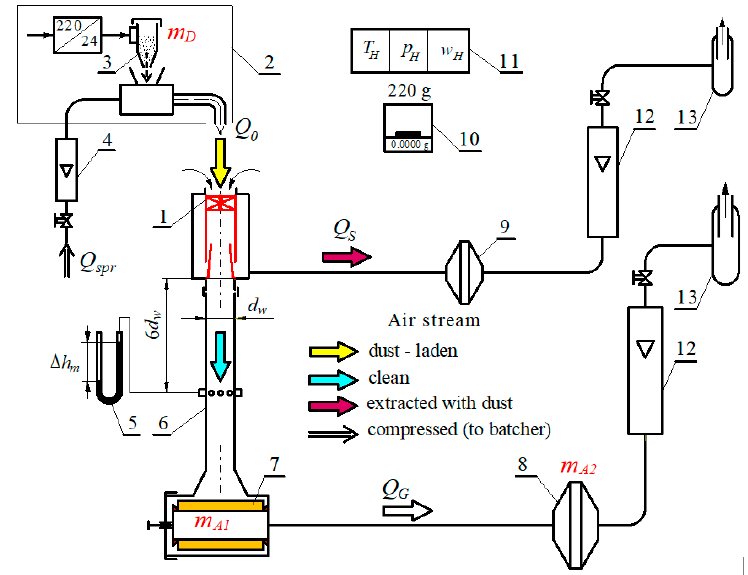
Figure 14. Functional diagram of the test stand for axial-flow cyclones: 1—tested axial flow cyclone, 2—dust dispenser, 3—dust container, 4—compressed air measuring rotameter, 5—U-tube liquid manometer, 6—outlet pipe from cyclone 7—measuring absolute filter A1 of the main stream, 8—measuring absolute filter A2 of the main stream, 9—filter securing the suction stream rotameter, 10—analytical balance, 11—set for measuring humidity, ambient air temperature and pressure, 12—rotameters for measurement main air stream Q G and extraction Q S , 13—fans forcing the air stream flow.